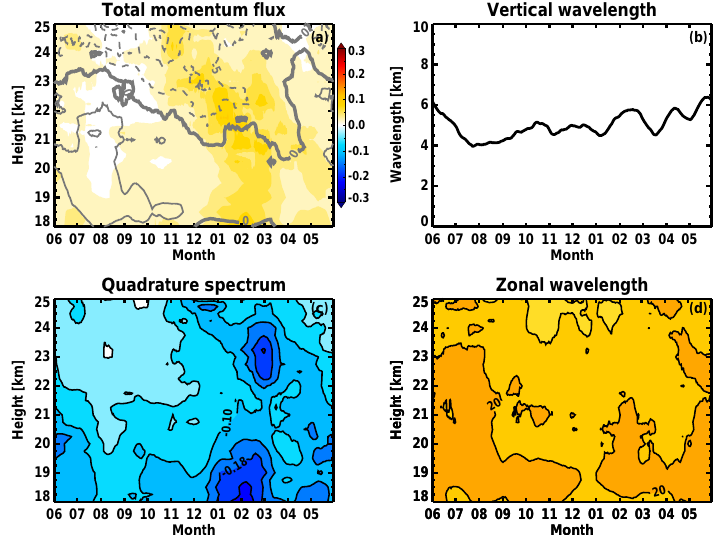
Figure 6. Climatology of momentum flux and related fields from the Manus ARM sounding site. (a) The 5–20-day total momentum flux (mPa) in shading and zonal mean zonal wind in contours. (b) The vertical length scale L z (km). (c) The quadrature spectrum Q uT (Kms − 1 ). (d) The horizontal length scale L x (1000km) with contour spacing of 5000km. The vertical wavelength, quadrature spectrum, and zonal wavelength are means over all wave periods and all fields are smoothed with a 21-day boxcar